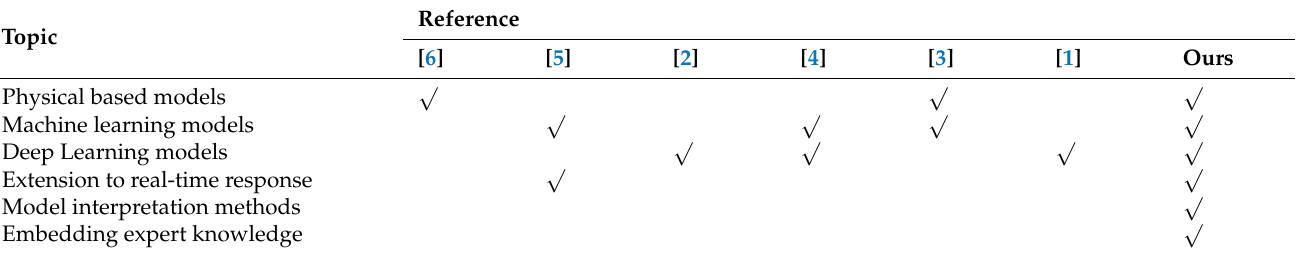
Table 1. Comparison of our systematic review to other related